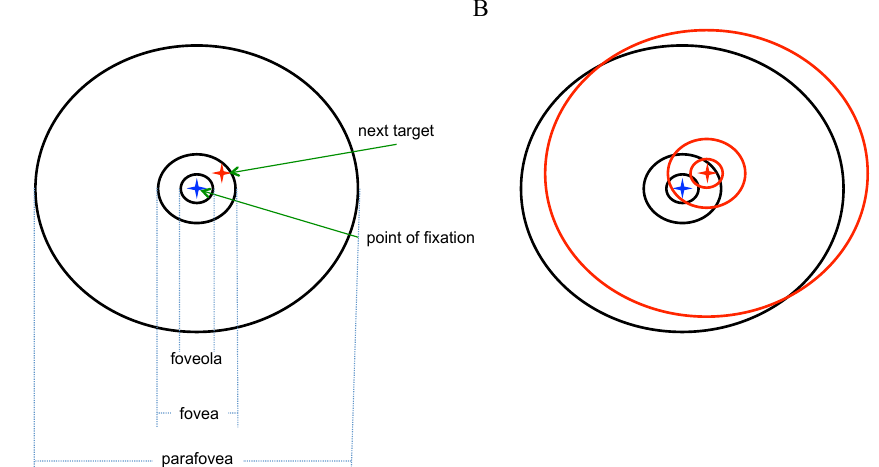
Figure 3. A: The physical layout of foveola (subtends 0.5° with a diameter of 0.35mm), fovea (subtends 2° with a diameter of 1.2mm) and parafovea (subtends 5° with a diameter of 2.5mm). The point of current fixation is the center of the foveola and the next fixation target is shown as a red star. B: Red indicates the position of the retina after the new fixation point is centered